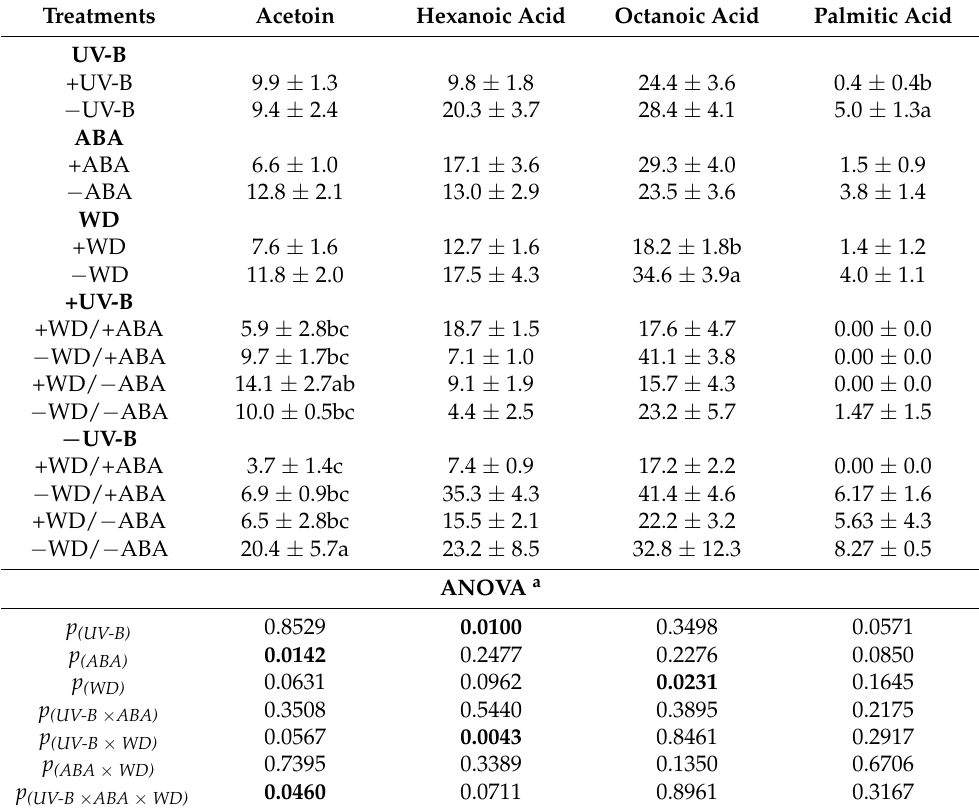
Table 6. Acetoin and volatile organic acid ( µ g L − 1 ) determined in wines from Malbec plants exposed to combined UV-B, WD and ABA